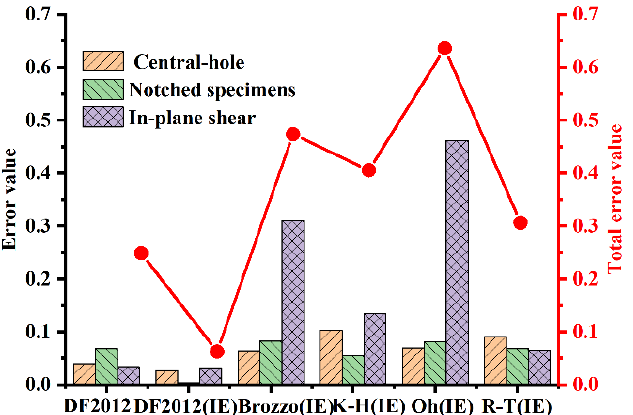
Figure 16. Error comparison of load-stroke predicted by different ductile fracture criteria.